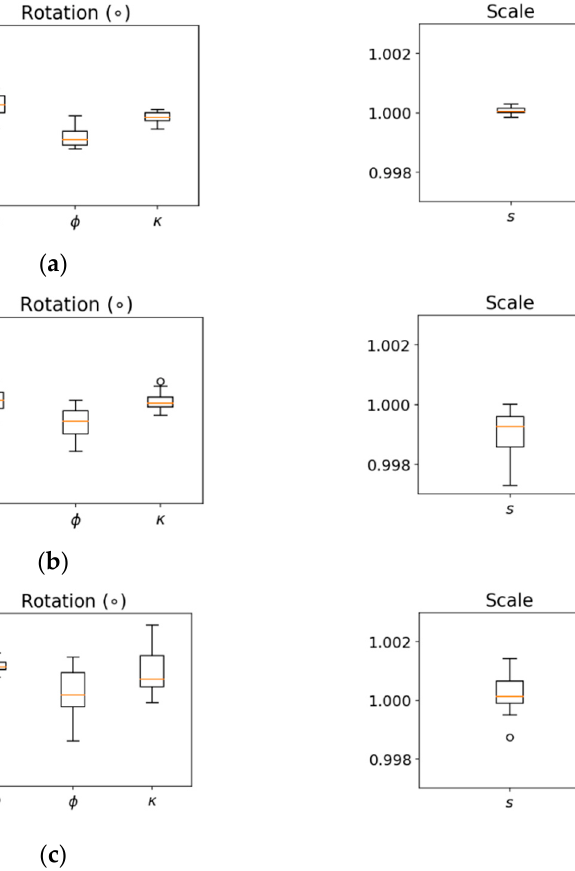
Figure 15. Box and whisker plots of the fine-registration transformation parameters for the ( a ) TLS, ( b ) PWMMS-HA, and ( c ) PWMMS-UHA datasets.